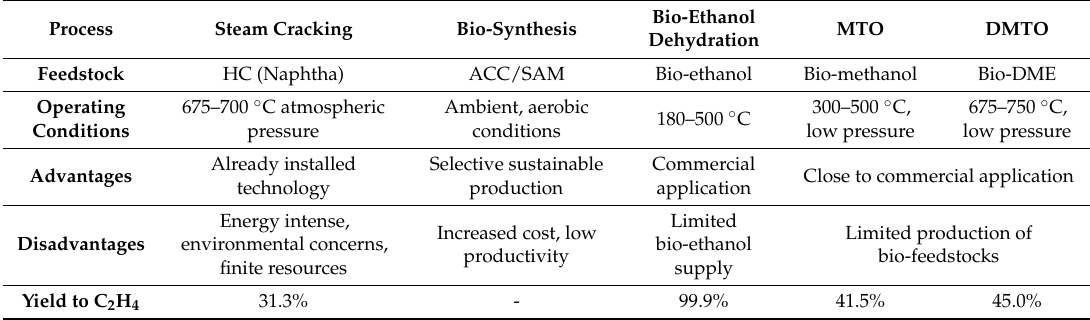
Table (cid:561) 2. (cid:561) Comparison (cid:561) of (cid:561) C 2 H 4 (cid:561) production (cid:561) processes. (cid:561) Table 2. Comparison of C 2 H 4 production